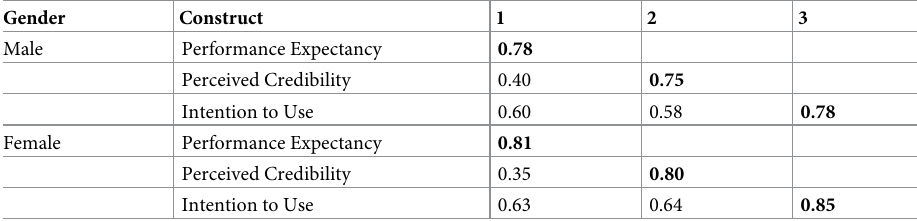
Table 4. Correlation matrix for male and female cardholders.